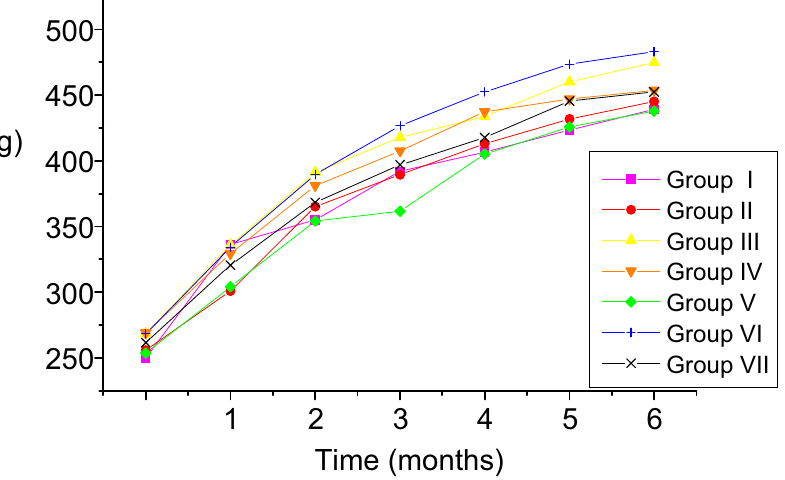
FIGURE 1 – Rats weight (grams) during the